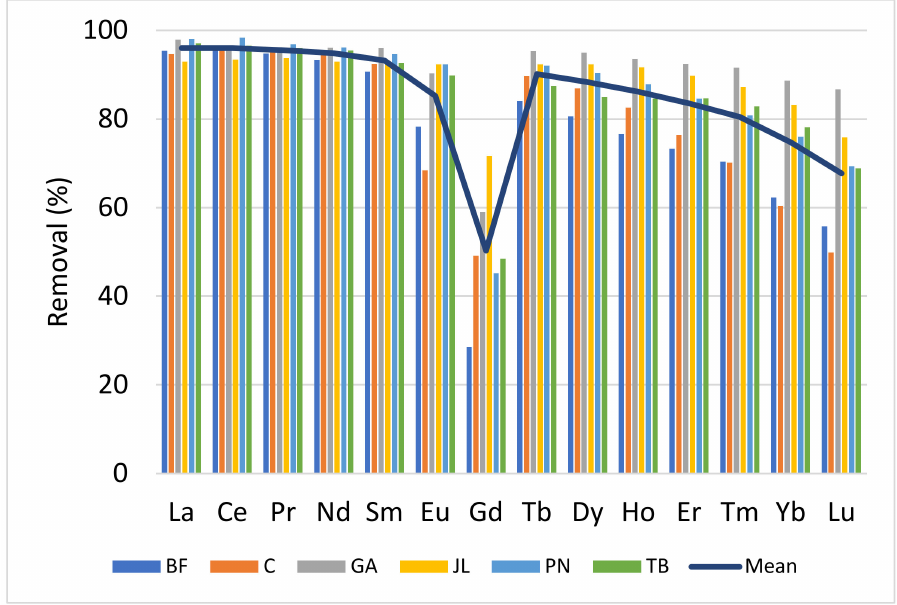
Figure 4. Removal efficiency of total lanthanides in various municipal wastewater treatment